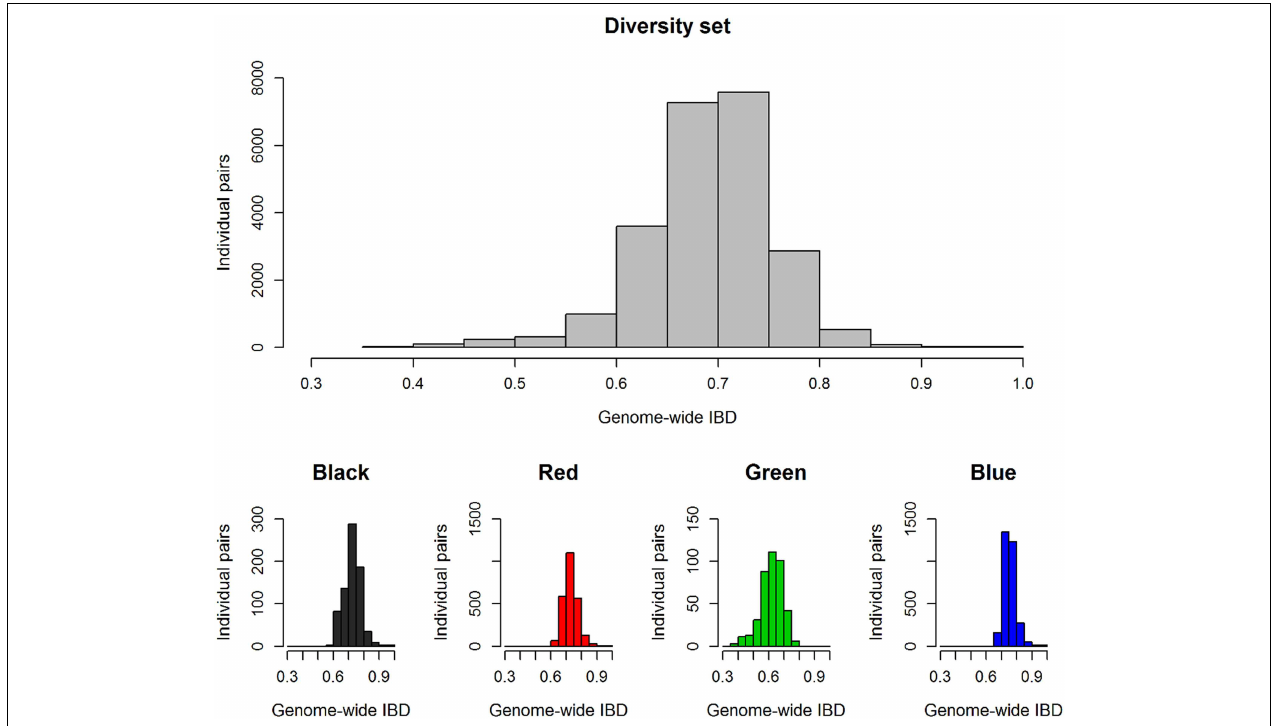
FIGURE 2 | Genetic relationship between all individual pairs within the total diversity set ( n = 218 ) and within the single clusters from k-means clustering. Histograms show the frequency of individual pairs depending on their kinship coefficients IBD (identity by descent) which score allelic identity by descent.